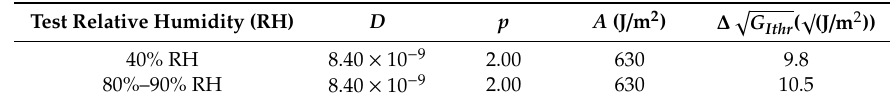
Table 3. Values of the parameters employed in the representation of Mode I crack growth in “FM300K”, from [60].